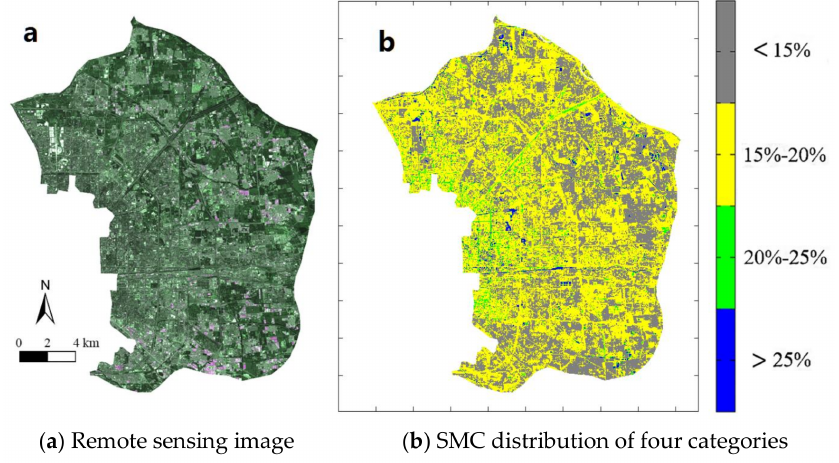
Figure 10. The remote sensing image and SMC distribution in the Chaoyang